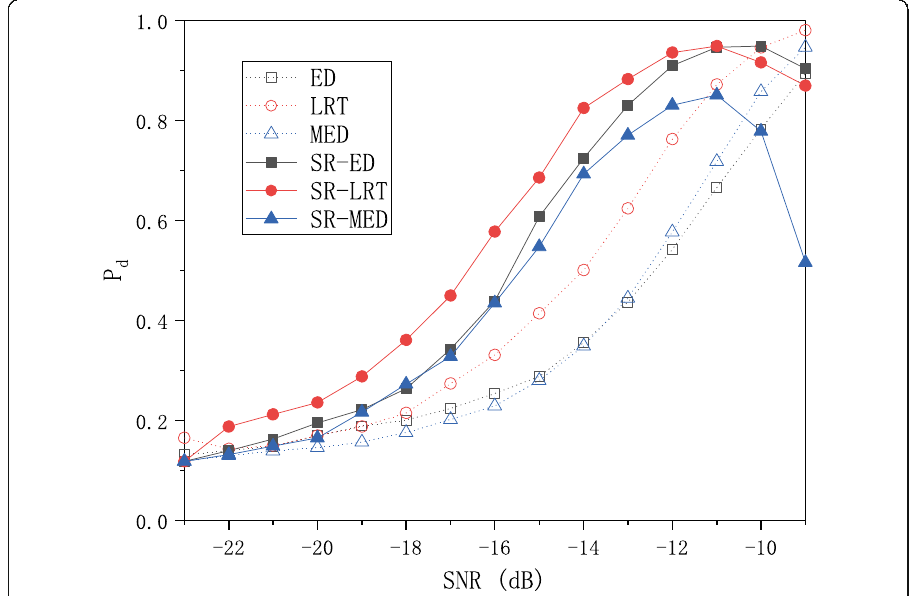
Fig. 9 The comparison of detection probability under Rayleigh channel with